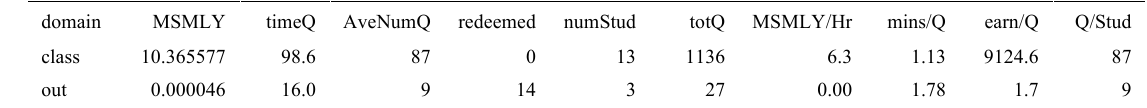
Table 3. Summary statistics after converting self-registrations to faucets for students inside and outside the tutor-web